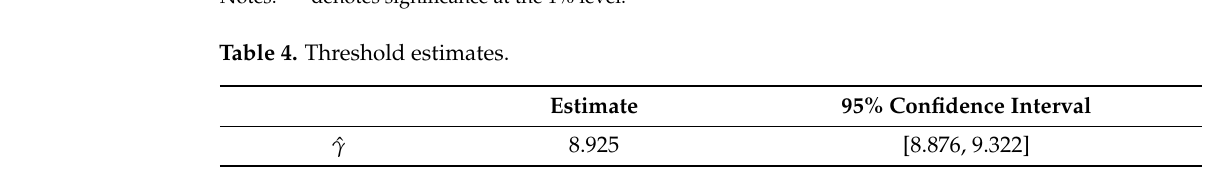
Table 5. Estimation results of panel threshold model of determinants of